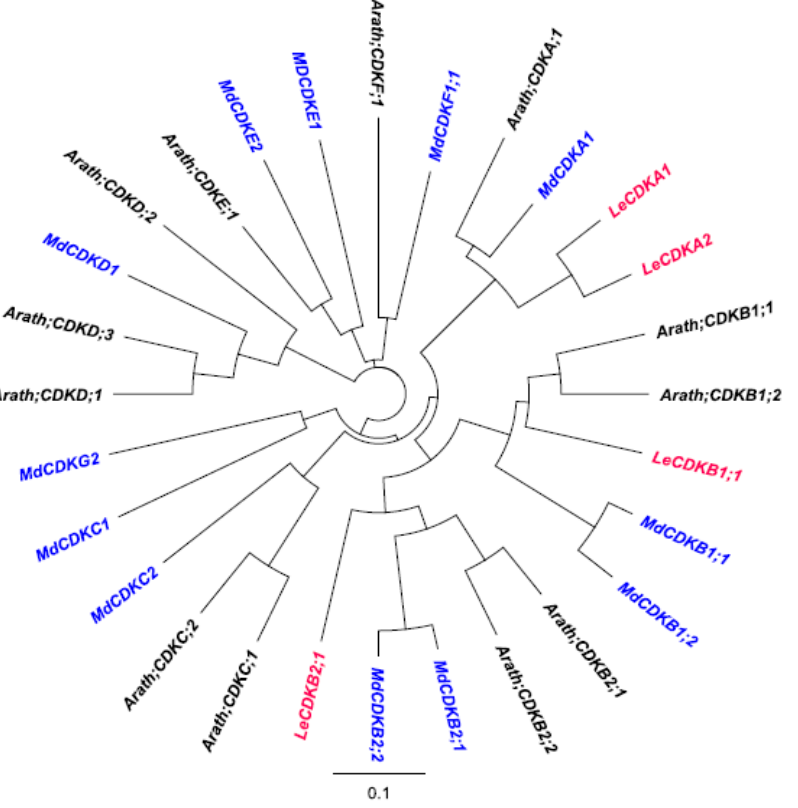
Figure 11. Phylogenetic tree of the Cyclin Dependent Kinases (CDKs). The CDKs from apple (blue), Arabidopsis (black,) and tomato (red) were aligned on the MUSCLE software. Parameters for phylogenetic tree building were set to neighbour joining and 500 bootstraps. Md: Malus x domestica , Arath: Arabidopsis , Sl: Solanum lycopersicum